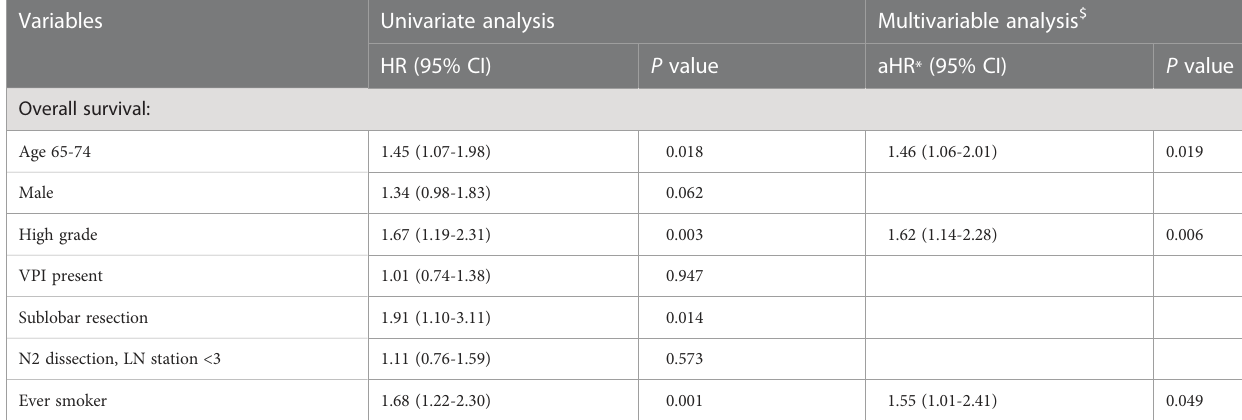
TABLE 2B Group 2: tumor >3 cm, but <=4